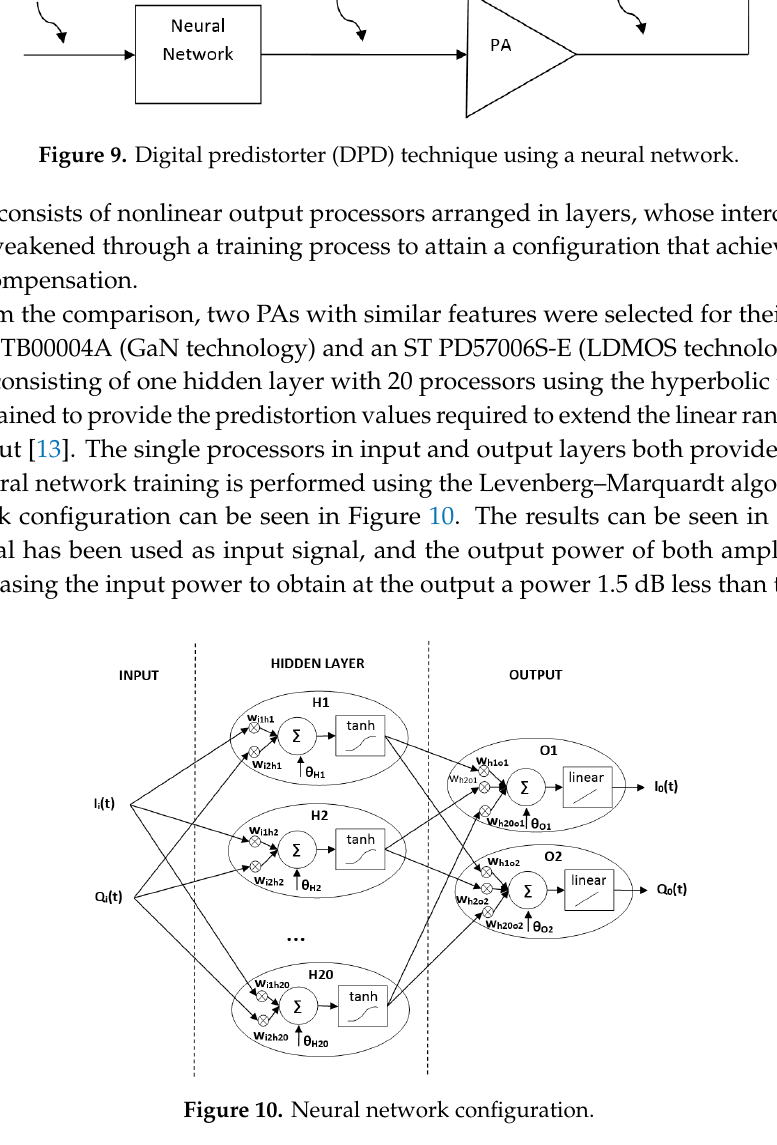
Figure 10. Neural network configuration.